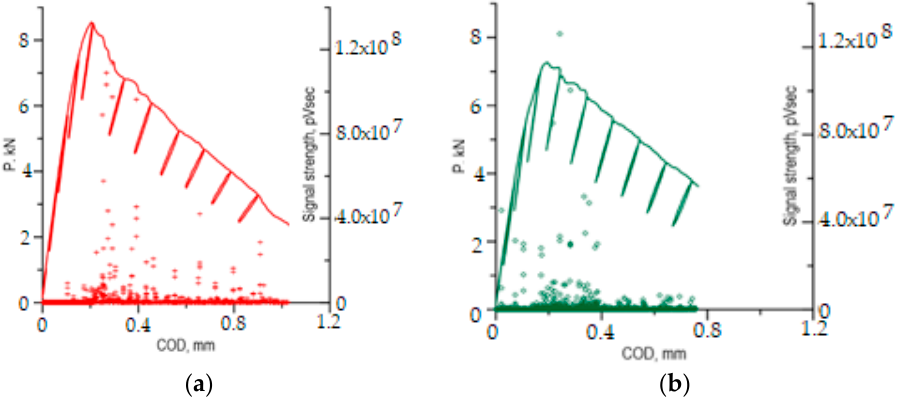
= 20 ◦ C; ( b ) T = − 50 ◦ 1 2